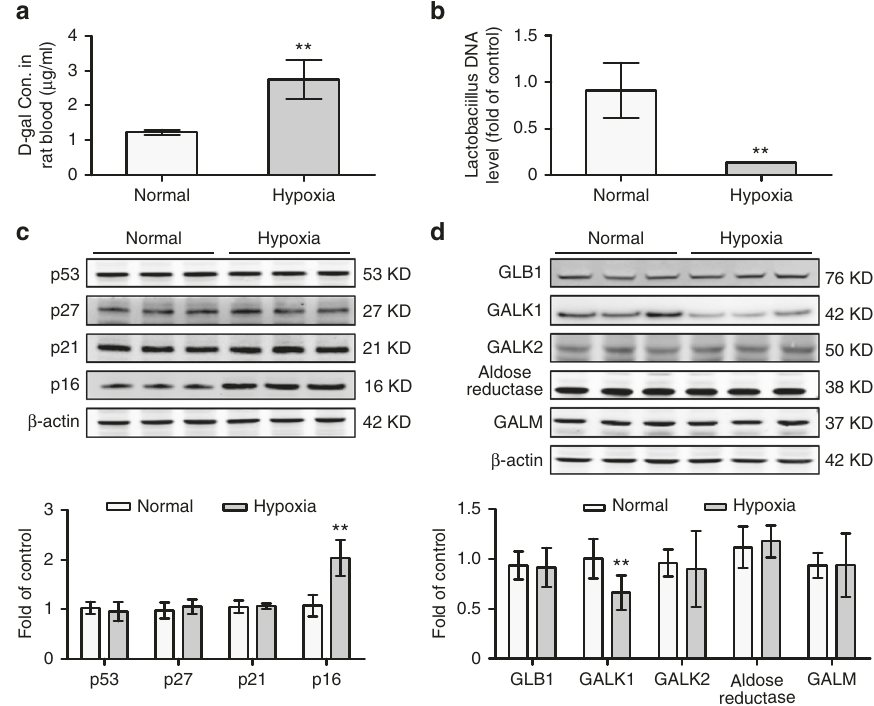
Fig. 5 Accumulation of D -galactose and BMSC dysfunction in a rat chronic hypoxia model. a New-born Sprague-Dawley rats were housed in normoxic or hypoxic chambers for 3 weeks, respectively ( n = 9 per group). Peripheral blood samples were obtained, and the D -galactose concentrations were measured. b Stools from the rats described in a were subjected to qPCR to assess the Lactobacillus content. c BMSCs from a were cultured to passage 3, and cell lysates were prepared to assess the levels of p53, p27, p21, p16 and β -actin by western blotting. d Western blotting was used to assess the protein levels of GALM, GALK1, GALK2, aldose reductase, GLB1 and β -actin in the rat liver. The data are the mean ± SD from three independent experiments, and statistical signi fi cance was analysed using Student ’ s t -test (** P <